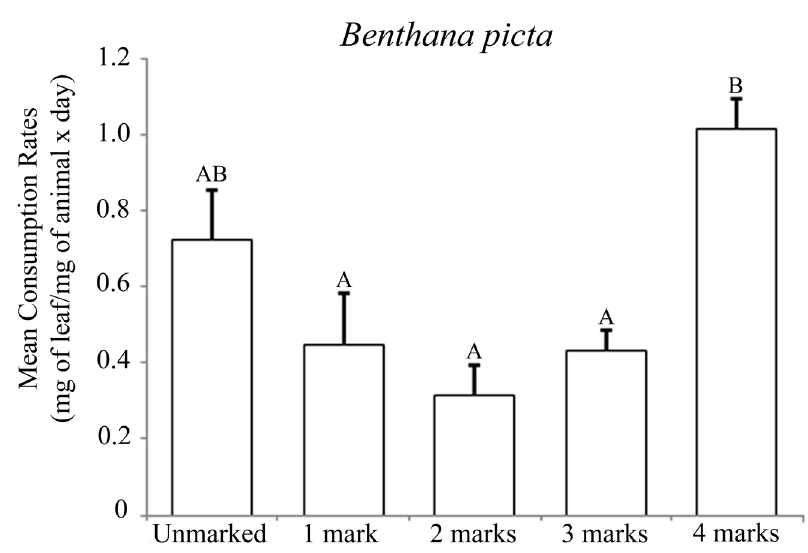
Figure 9. Mean relative consumption of Benthana picta fed with three leaf disks of M. stipitatum during 10 days of experiment. Each treatment corresponding to the number of nail polish external marks on animals’ cuticle (zero – unmarked, one, two, three and four). Vertical bars indicate standard error. Different letters above the bars show statistical difference through analysis of variance (ANOVA) and post-hoc Tukey’s test